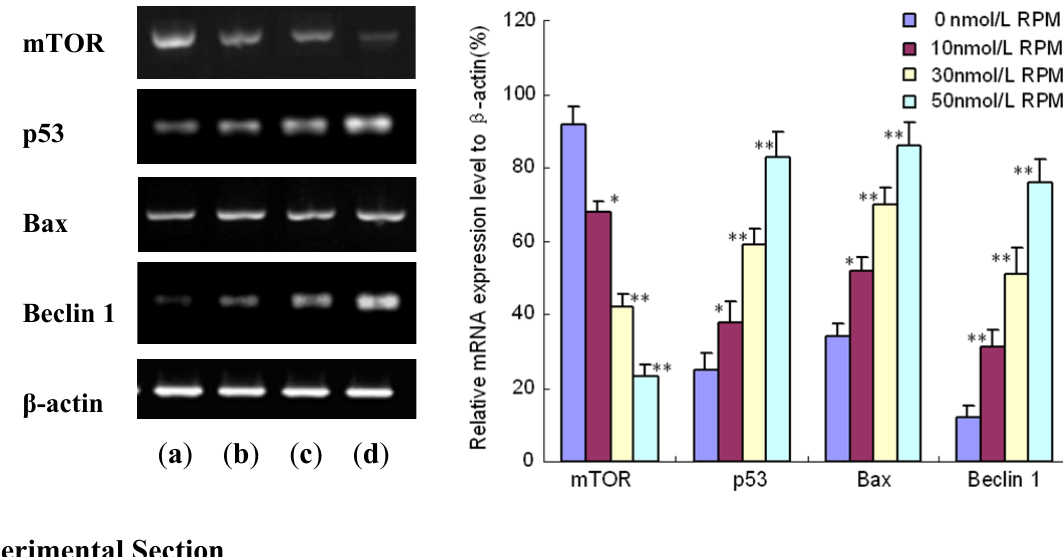
Figure 5. The mRNA expression of mTOR, p53, Bax and Beclin 1 in PC-2 cells treated with different concentrations of Rapa: After treatment with different doses of Rapa for 24 h, mRNA level was detected by semi-quantitive RT-PCR analysis. This assay was done quintuplicate. Values represent means ± standard deviations and were determined using the Student’s t-test. * p < 0.05 and ** p < 0.01 versus 0 nmol/L Rapa